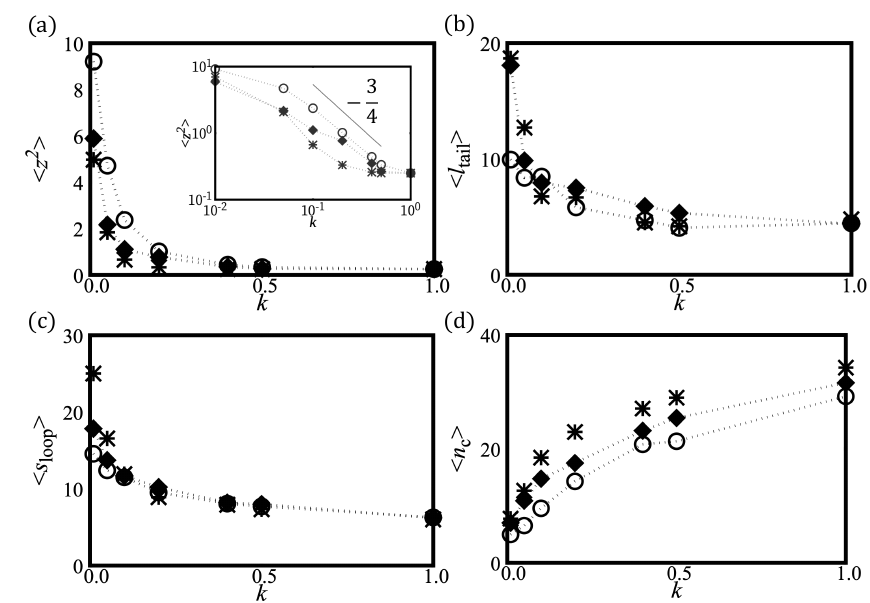
Figure 2. Various measured properties of H-filaments, consisting of N = 90 monomers, confined by a kz 2 . One end is anchored at z = 0. Symbols ◦ , filled (cid:5) , and ∗ , respectively, harmonic potential V ( z ) = 1 2 stand for: (i) γ > 1; (ii) γ < 1; and WLCT ( ω 1 = ω 2 = ω 3 = 0). ( a ) The height fluctuation (cid:104) z 2 (cid:105) as the function of the stiffness k of the harmonic potential. The solid line represents analytical calculation in weak fluctuation limit (Equation (11)) for Case (i), ω 1 = 0.18 σ − 1 , and ω 3 = 0.10 σ − 1 . The inset shows mean squared height (cid:104) z 2 (cid:105) as a function k on log-log scale. The solid line is used to guide the eye for the exponent in relation (cid:104) z 2 (cid:105) ∝ k − 3/4 expected for the WLC. ( b ) Average tail length (cid:104) l tail (cid:105) ; ( c ) average loop length (cid:104) s loop (cid:105) ; and ( d ) mean number of confined monomers (cid:104) n c (cid:105)